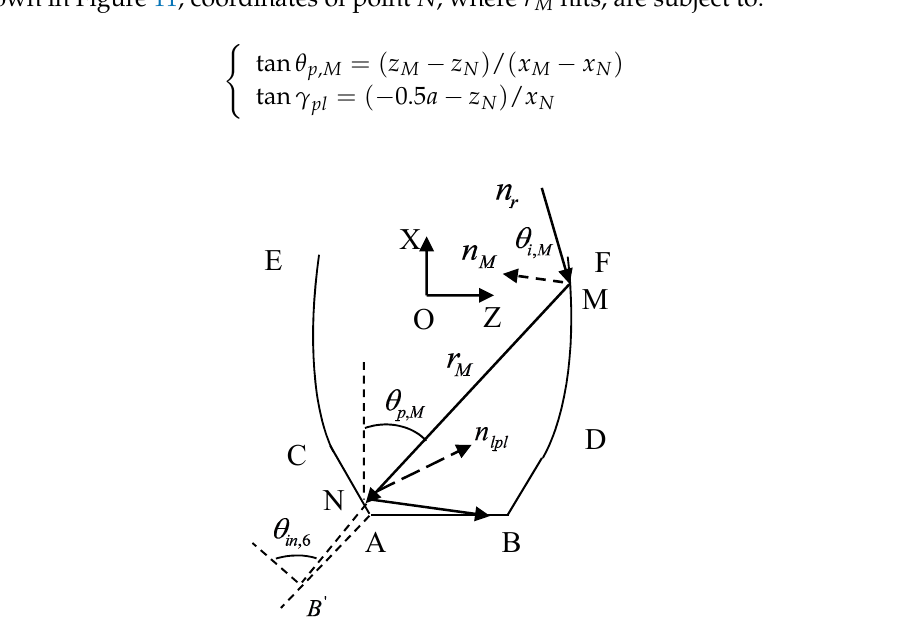
θ and critical point K for , 2 p c